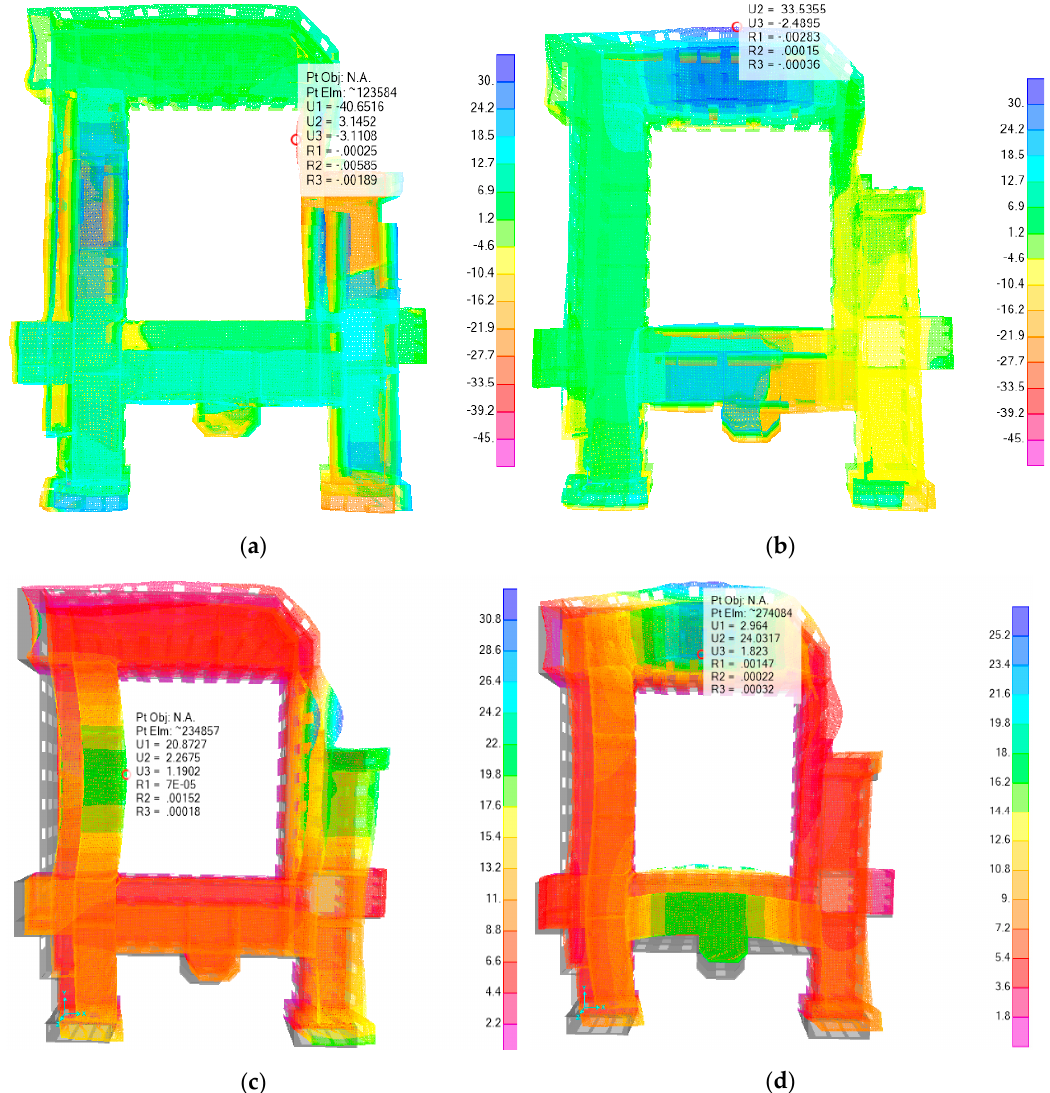
Figure 17. Deformation of the monument ( a ) before retrofitting along the x-direction, ( b ) before retrofitting along the y-direction, ( c ) after retrofitting along the x-direction, and ( d ) after retrofitting in the y-direction .